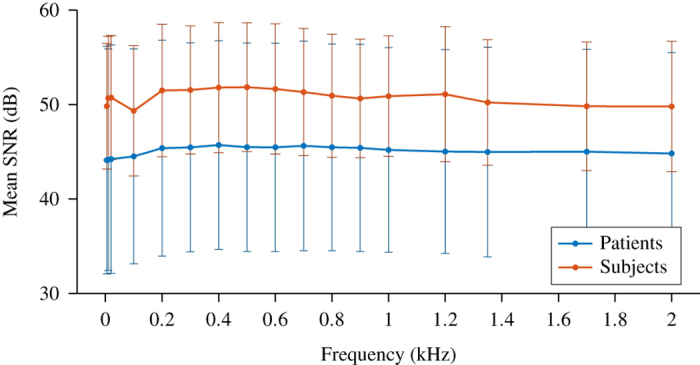
Signal to noise ratio across frequency (mean±standard deviation).There were no significant differences in SNR across frequency in both patient (N=18, n=24) and subject (N=10, n=20) recordings. There was an average 5 dB decrease in SNR in the patient recordings resulting from increased movement artefacts, although this was not significant at any frequency (P>=0.54).